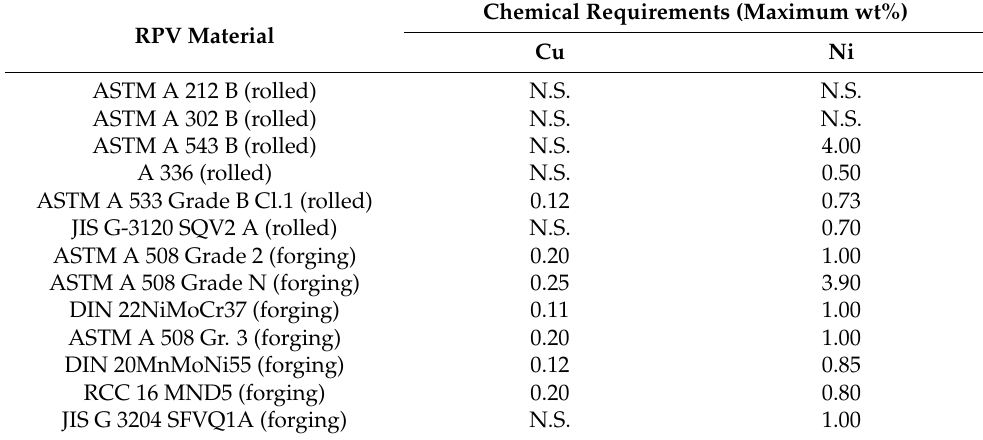
Table 2. Chemical limits used in the analysis.